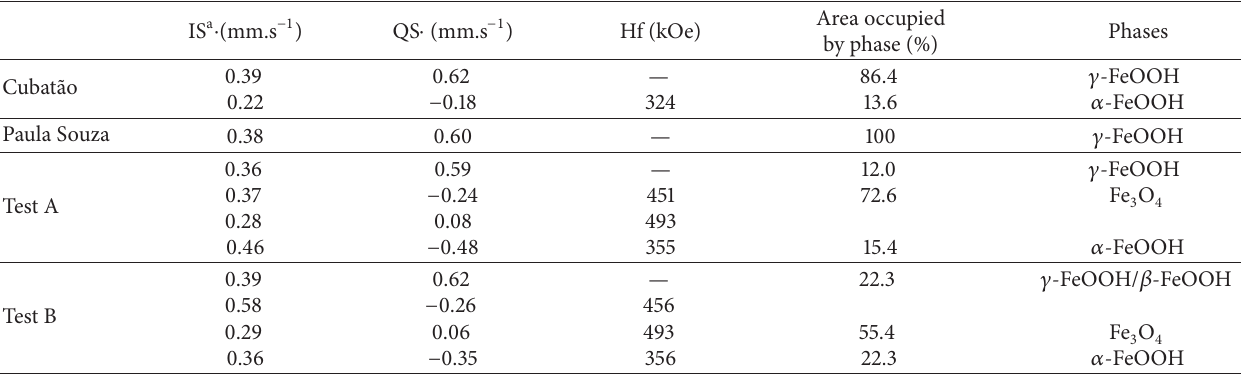
Table 2: M¨ossbauer parameters of the specimens exposed for nine months at Cubat˜ao and Paula Souza and to four cycles of the accelerated tests, A and B.